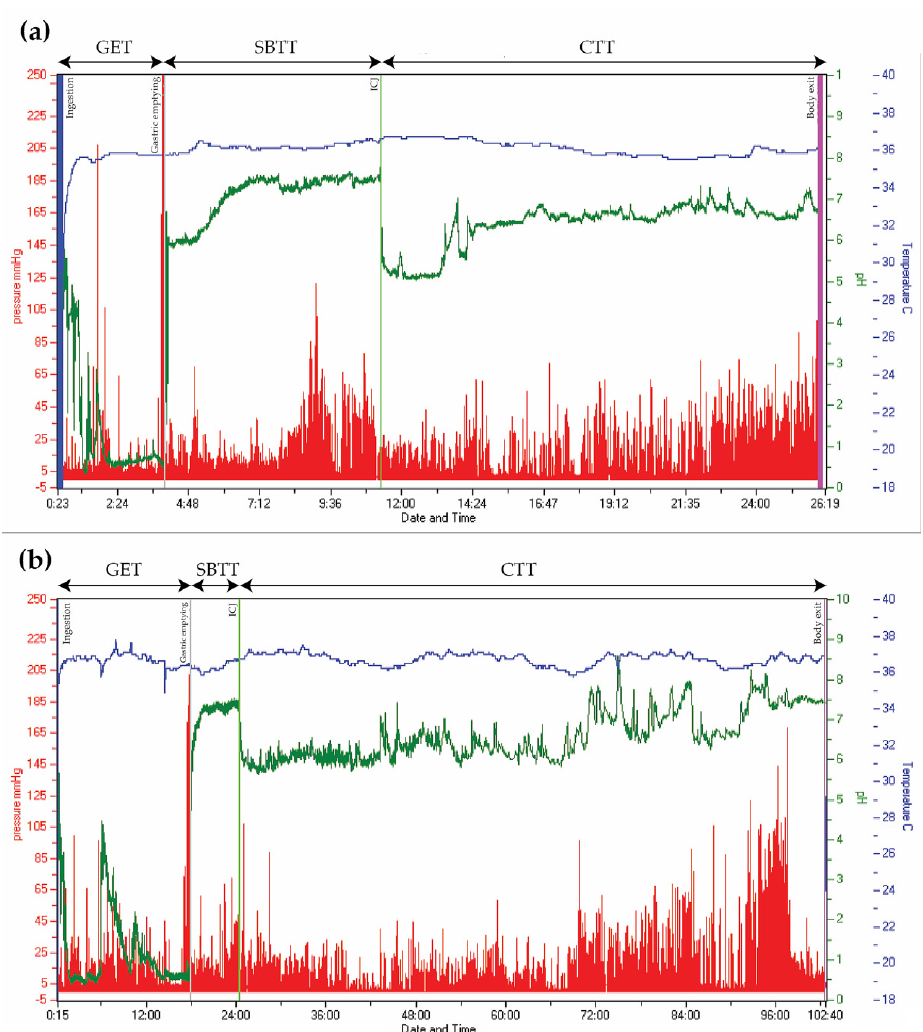
Figure 2. Wireless Motility Capsule recordings from two patients with type 2 diabetes. Time is displayed on the x-axis, pressure on the left y-axis (red), pH on the right y-axis (green), and temperature on the right y-axis (blue). ( a ) Normal transit times. ( b ) Delayed gastric emptying time (18 h) and colonic transit time (78 h). (GET = Gastric emptying time. SBTT = Small bowel transit time. CTT = Colonic transit time. ICJ = Ileocolic junction).